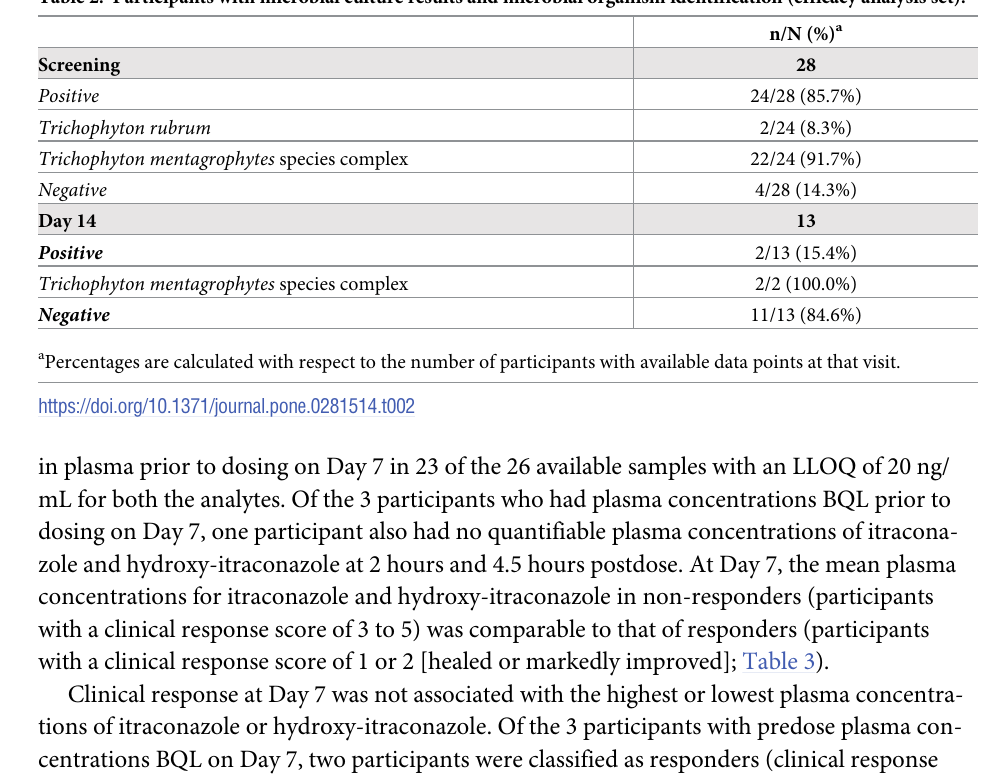
Table 2. Participants with microbial culture results and microbial organism identification (efficacy analysis set).